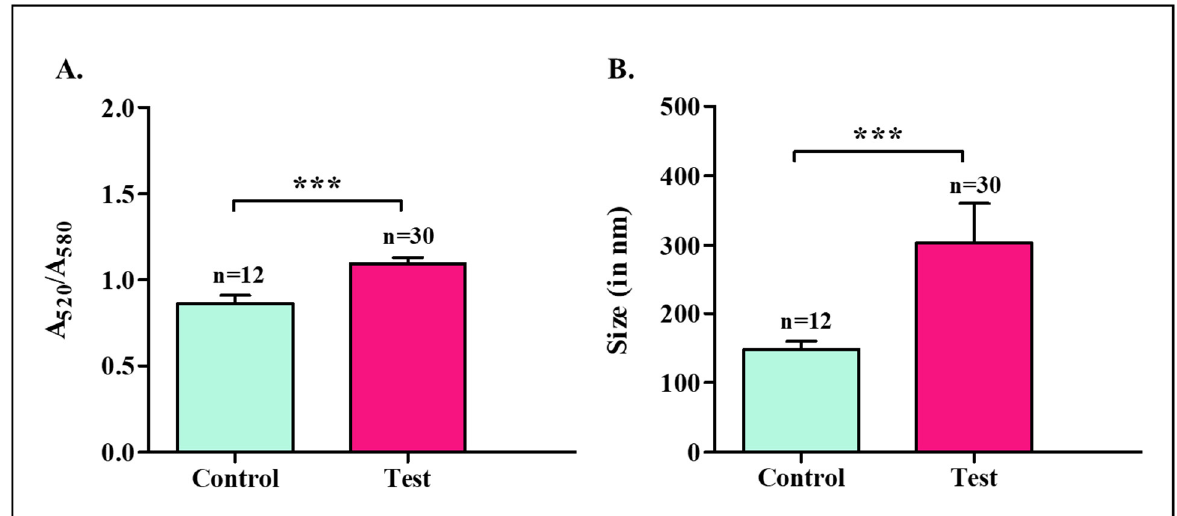
Figure 3. ( A ). Aggregation coefficient (ratio of spectral intensities at 520 nm to 580 nm) (*** p = 0.0002) and ( B ) size analysis of control and test nanoparticles (gold nanoparticles formed with healthy and cancerous samples, respectively) (*** p = 0.0001).